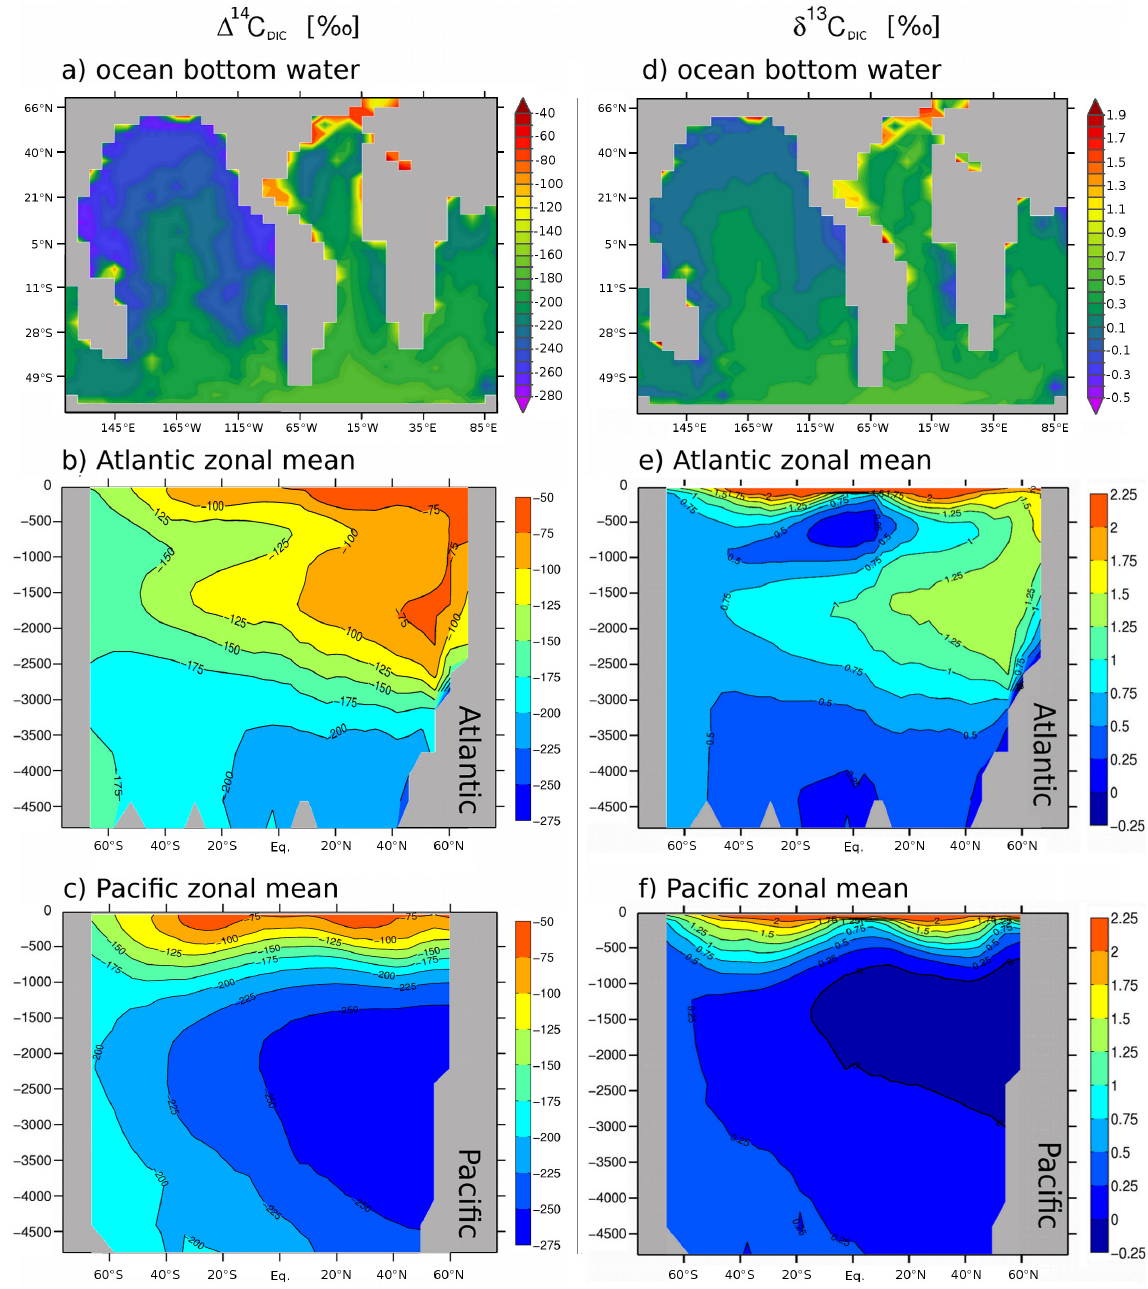
Fig. 2. Modelled distribution of the isotope signatures in ocean dissolved inorganic carbon for preindustrial boundary conditions. 1 14 C DIC is shown in the left row and δ 13 C DIC in the right row. Top panels (a) and (d) show bottom water signatures, the middle row panels (b) and (e) display Atlantic and bottom panels (c) and (f) Pacific zonal mean sections in preindustrial steady state. CaCO 3 is efficiently preserved (Fig. 3d, red line). As a